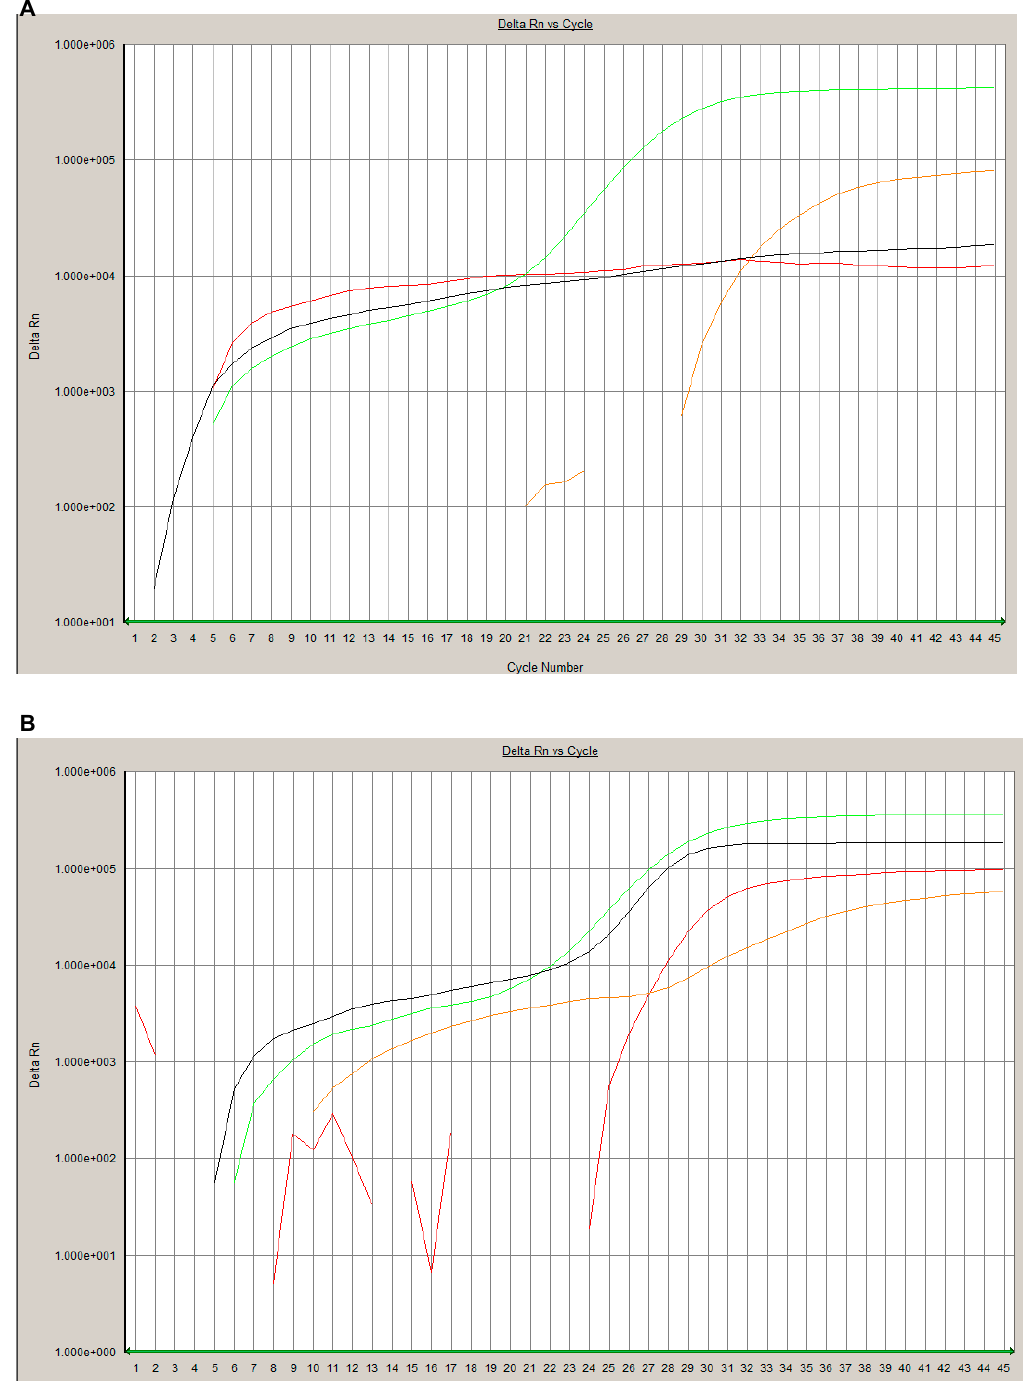
Figure 1. Examples for a positive and negative rRT-PCR result. A SARS-CoV-2 negative sample (( A ); ID 17) show a signal in the control RNA specific HEX channel (orange line) and process control channel ROX channel (green line). A SARS-CoV-2 positive sample (( B) ; ID 5) shows additionally a SARS-CoV-2 specific amplification in the FAM channel (red line) and beta-Coronavirus detection (E gene) in the Cy5 channel (black line).